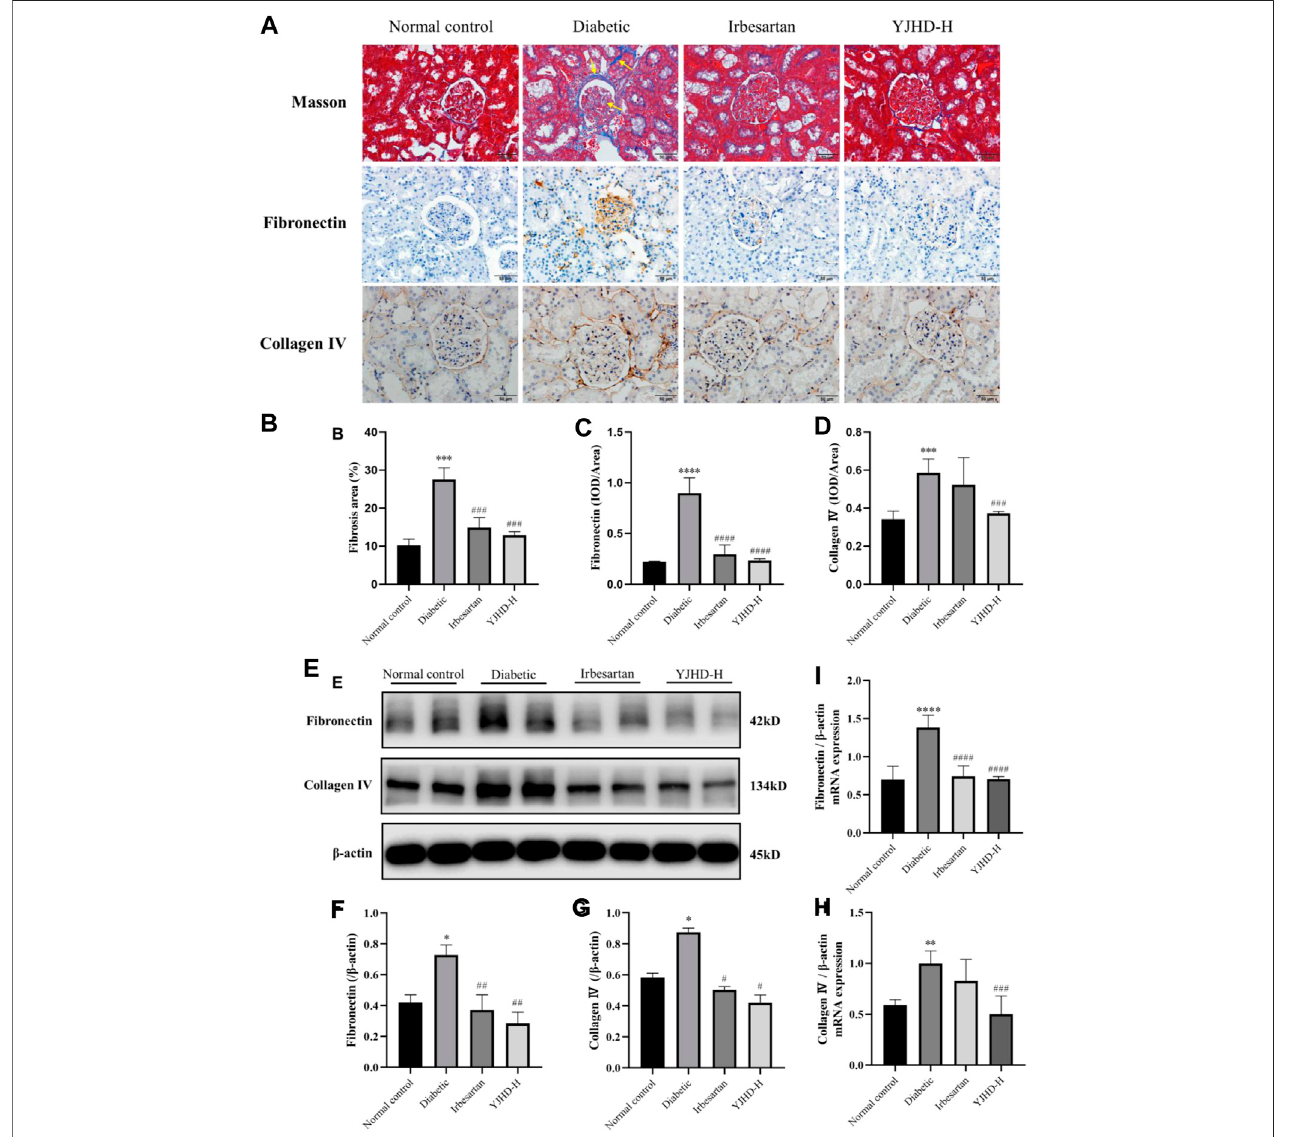
FIGURE 4 | Yiqi Jiedu Huayu decoction (YJHD) improves renal fi brosis. (A) Masson staining was used to analyze collagen fi bers in the kidney, and immunohistochemistry was used to analyze the expression of fi bronectin and collagen IV. In the diabetic group, collagen fi bers deposition (arrows) was observed in Masson staining. (B) ImageJ software was used to calculate the degree of renal fi brosis. (C, D) Image-Pro Plus software was used to statistically analyze immunohistochemical staining results of fi bronectin and collagen IV, respectively. (E) Protein levels of fi bronectin and collagen IV in the kidney were detected by westernblotting. (F,G) Proteinconcentrationanalysis. (H,I) mRNAexpressionlevelsof fi bronectinandcollagenIVinkidneysweredetectedbyPCR.Dataareexpressed as * p < 0.05, ** p < 0.01, *** p < 0.001, **** p < 0.0001: compared with the normal control group; # p < 0.05, ## p < 0.01, ### p < 0.001, and #### p < 0.0001: compared with the diabetic group,